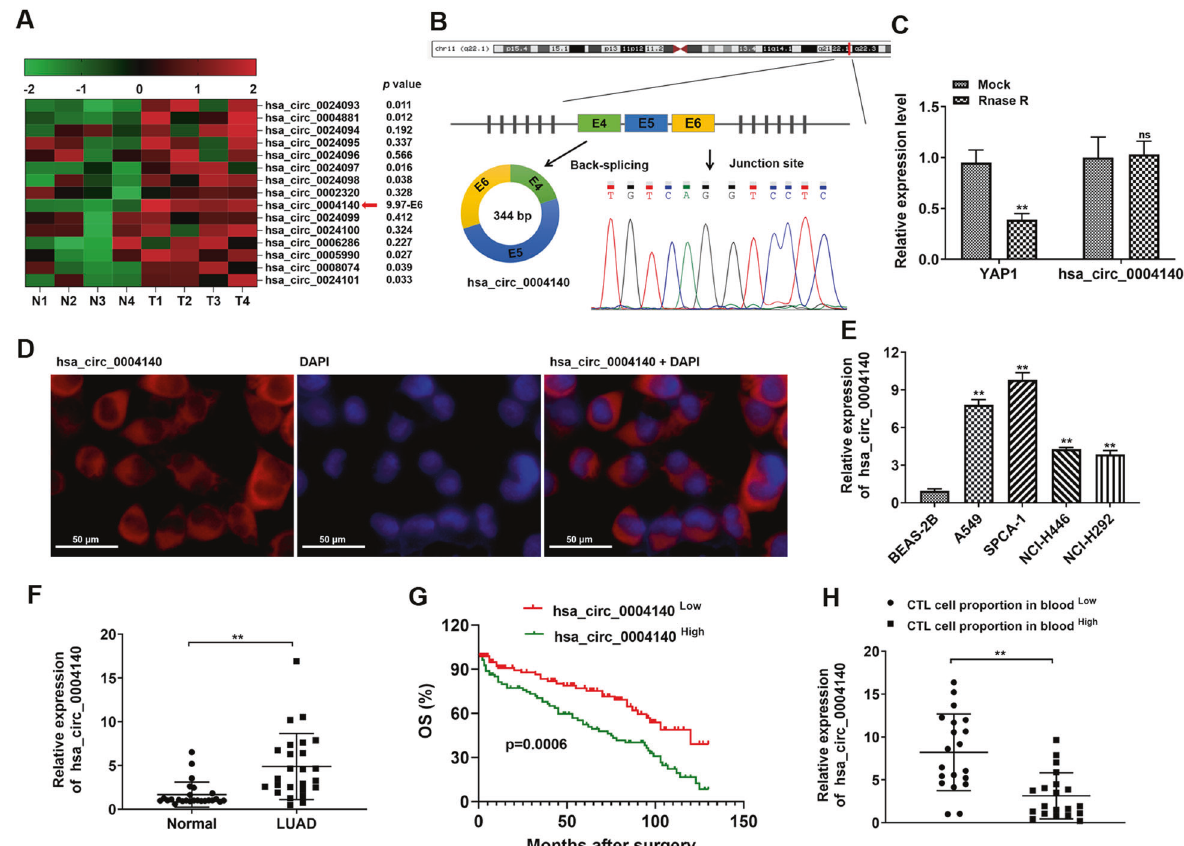
Fig. 1 circ_0004140 is up-regulated in LUAD. A Heat map representing expression of 15 circRNAs derived from YAP1 in 4 pairs of LUAD tissues and adjacent normal tissues detected by RT-PCR analysis. Circ_0004140 was the most signi fi cantly up-regulated in LUAD samples. B Schematic illustration indicated circ_0004140 was generated from exons 4 – 6 of YAP1 gene. Sanger sequencing revealed the junction site of circ_0004140. C Resistance of circ_0004140 to RNase R was veri fi ed through qRT-PCR after RNase R digestion ( n = 3). D The cellular distribution of circ_0004140 was analyzed by fl uorescence in situ hybridization (FISH) ( n = 3). Red indicates circ_0004140. Nuclei were stained with DAPI. Scale bar = 50 μ m. E , F circ_0004140 was up-regulated in LUAD cell lines (A549, SPCA-1, NCI-H446, and NCI-H292) (E) compared with BEAB-2B cells ( n = 3) and in LUAD clinical samples (F) ( n = 25). G Kaplan – Meier analysis of overall survival in LUAD patients with high circ_0004140 expression ( n = 80) and low circ_0004140 expression ( n = 80). H 40 LUAD patients were divided into high and low groups based on CTL